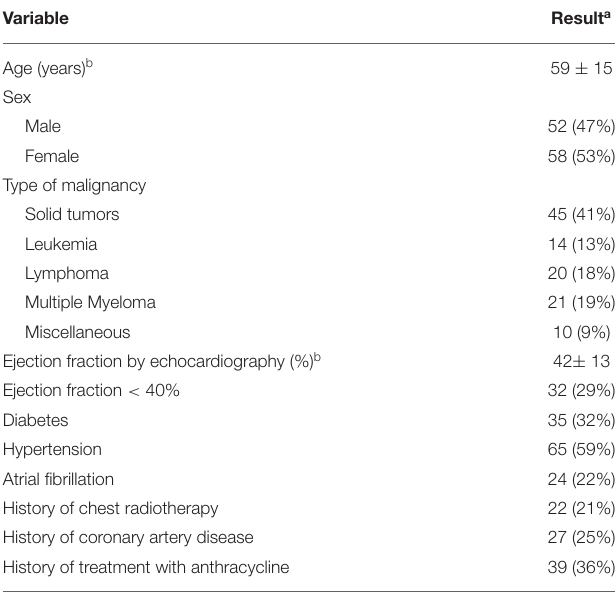
endpoints as previously defined.